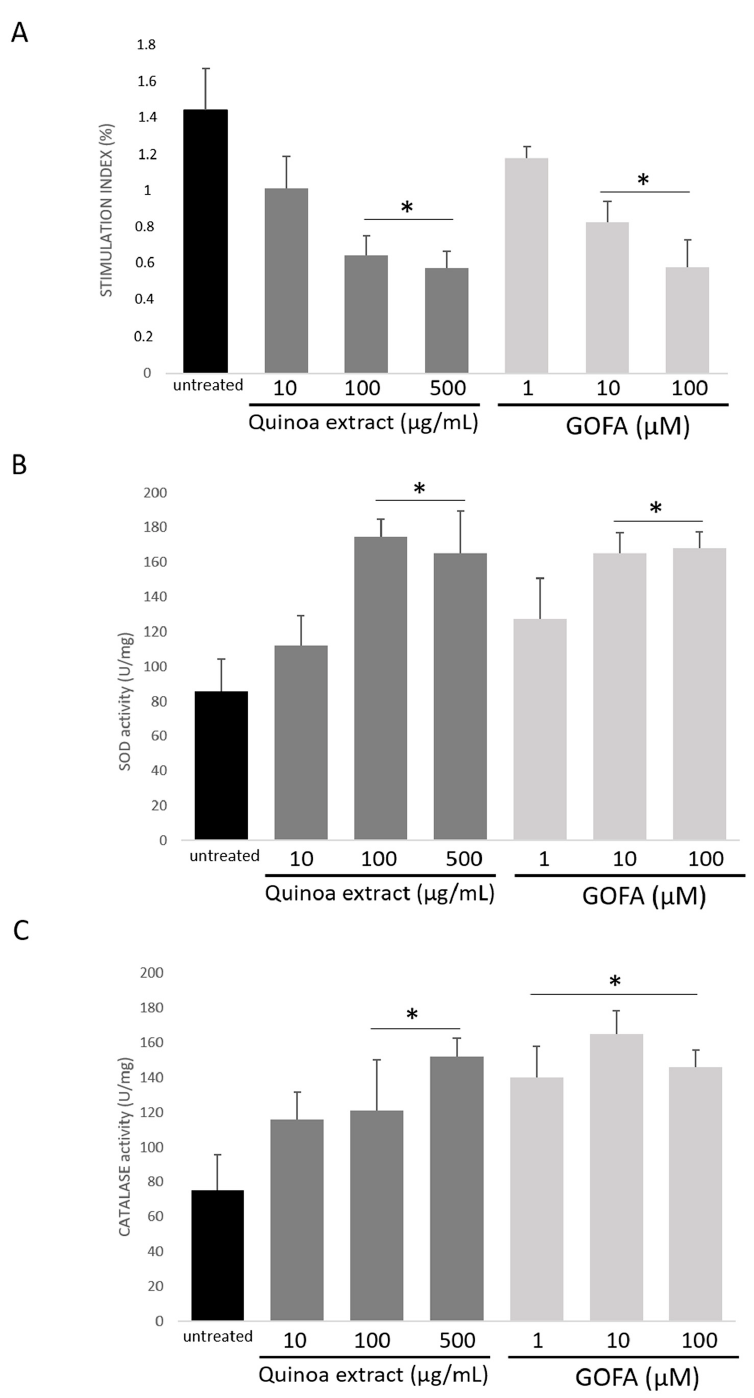
Figure 2. The effect of quinoa extract and GOFA on reactive oxygen species (ROS) production and anti-oxidative enzyme activity in HCT116 cells. ( A ) ROS production was measured by NBT assay. ( B ) Superoxide dismutase (SOD) and ( C ) catalase activity were analyzed. The results are representative of three different assays. Data are expressed as the mean ± SD. * p < 0.05 vs. untreated cells.